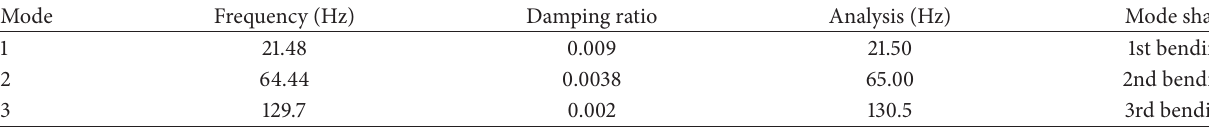
Table 2: Frequencies and damping ratios of free-free beam.